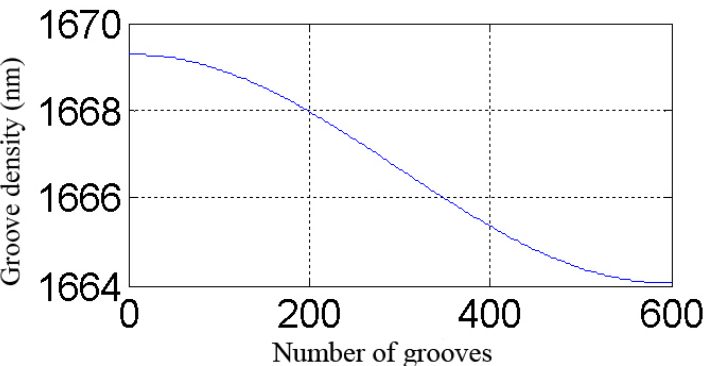
Figure 6. The distribution function of the period of the unit ghost line in the groove.